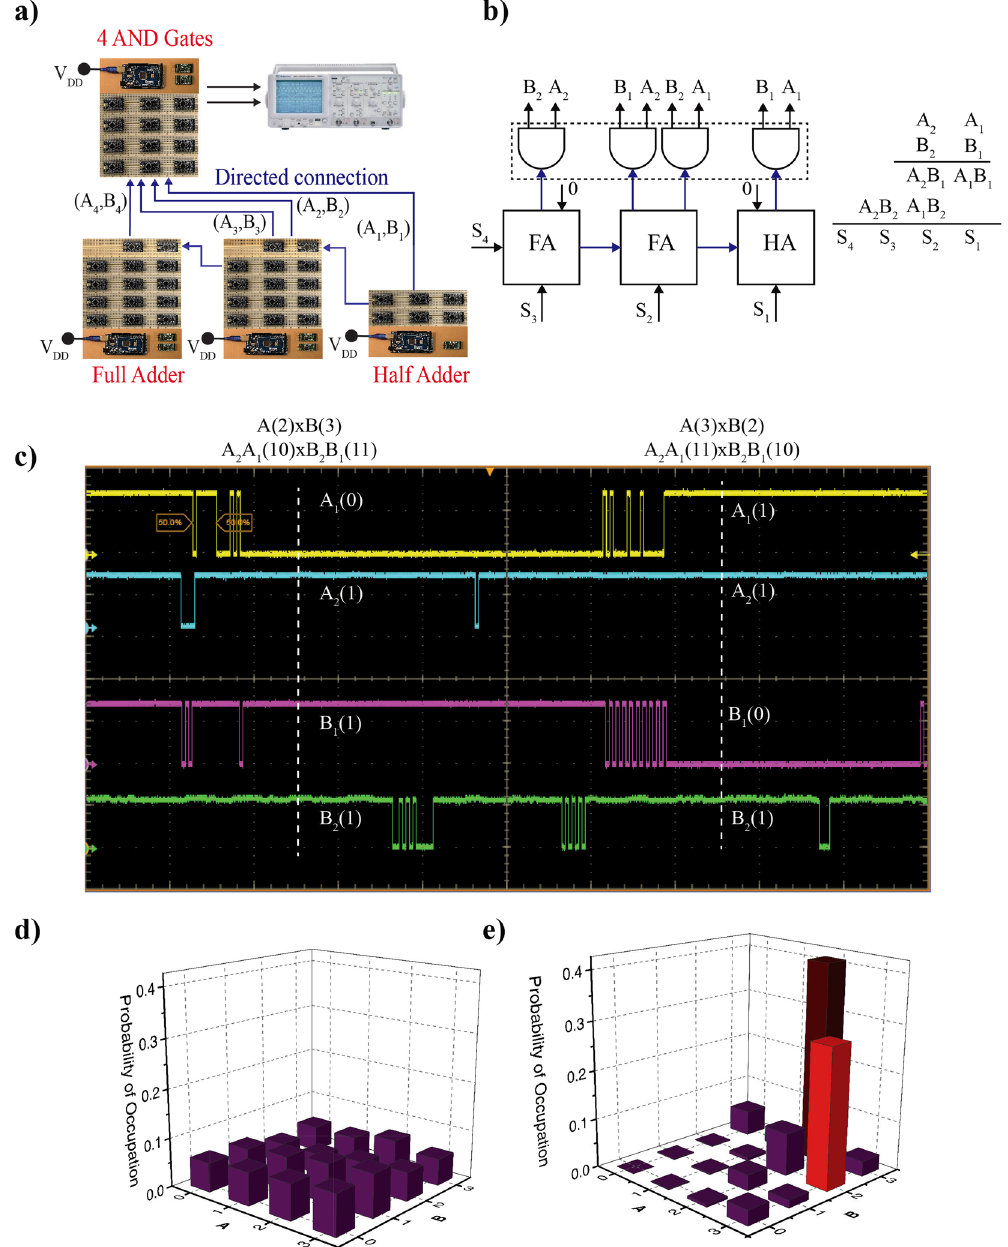
Figure 9. 4-bit multiplier/factorizer. A 4-bit multiplier constructed out of 3 Full Adders and 4 AND gates working in inverted mode operates as factorizer. A schematic and a block diagram are shown in ( a ) and ( b ). ( c ) When the sum of the 4-bit adder (product of the multiplier) is clamped to 6, the inputs A and B fluctuate between decimal 2 and 3 with approximately equal probability for the correlated system ( e ). For the uncorrelated system ( f ), the inputs fluctuate randomly among 16 possible